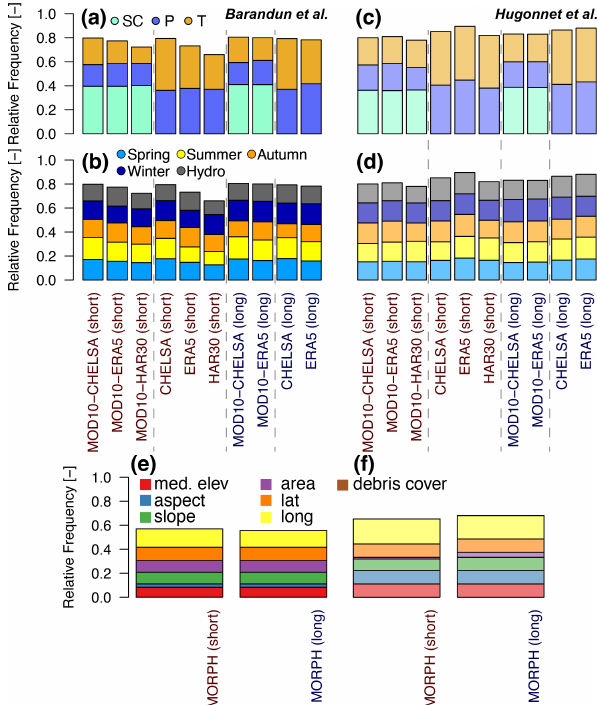
Figure 6. Importance of (a, c) climatic variables, (b, d) season, and (e, f) morphological parameters for all of Tien Shan and Pamir. (a, b, e) Solid colors refer to MB Barandunetal , and (c, d, f) semitrans- parent colors refer to MB Hugonnetetal . Labels short and long refer to the periods 2000–2014 and 2000–2018, respectively. For the mor- phological analysis this refers to the glacier mass balance